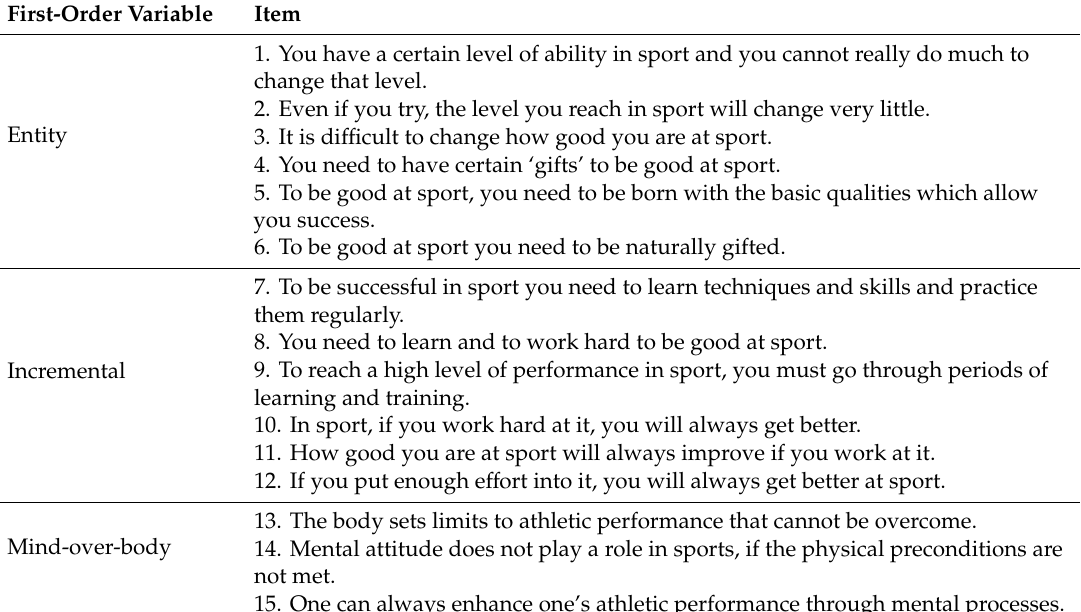
(Table 1, Items 13–15) to measure mind-over-body beliefs (Cronbach’s α = 0.55). These three items were averaged into a composite score with higher values indicating that the mind rather than the body is seen as limiting athletic ability. Answers were given on a five-point Likert scale from 1 ( strongly disagree ) to 5 ( strongly agree ). Finally, participants reported a number of demographic information (i.e., age, physical activity, main sports). Table 1. Items used for measuring entity and incremental beliefs (CNAAQ-2; [42]), complemented by three items measuring implicit theories about the body versus the mind as limiting factors of athletic performance (i.e., mind-over-body